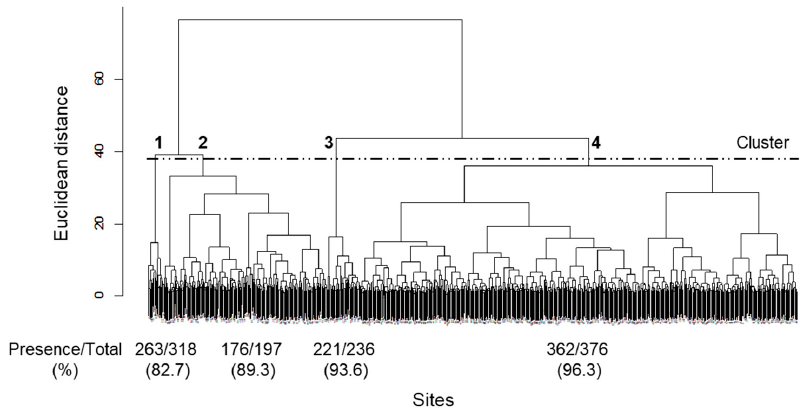
Figure 2. A dendrogram of hierarchical cluster analysis based on the similarities of 13 environmental factors. The dotted line indicates the clustering point. Presence/Total (%) indicates the number of sites with presence of Limnodrilus hoffmeisteri among the number of sites assigned in each group, and the percentage is the proportion of the number of sampling sites with presence of L. hoffmeisteri .